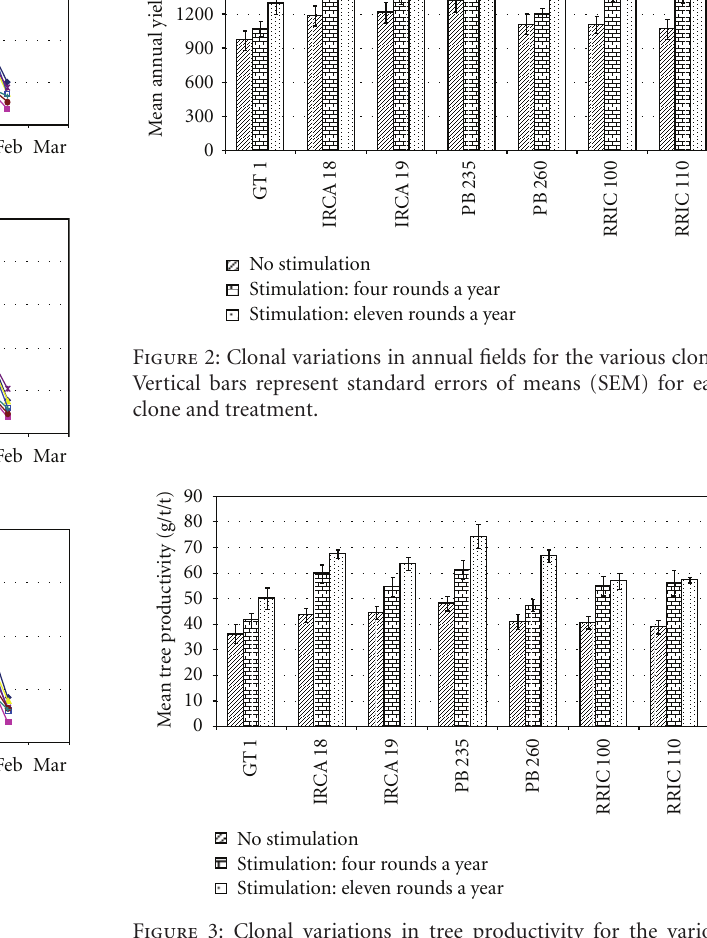
Figure 3: Clonal variations in tree productivity for the various clones. Vertical bars represent standard errors of means (SEM) for each clone and